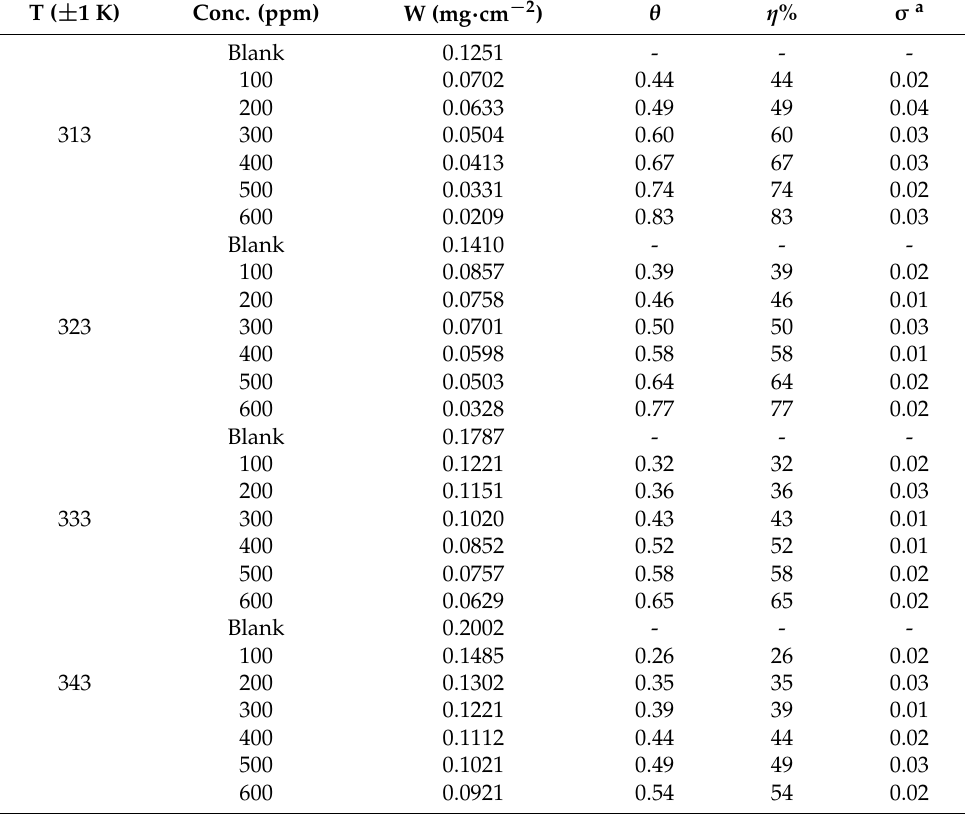
Table 2. The η % values for various concentrations (Conc.) and temperatures of C. tagal extract for mild steel corrosion in 1 M HCl by weight loss